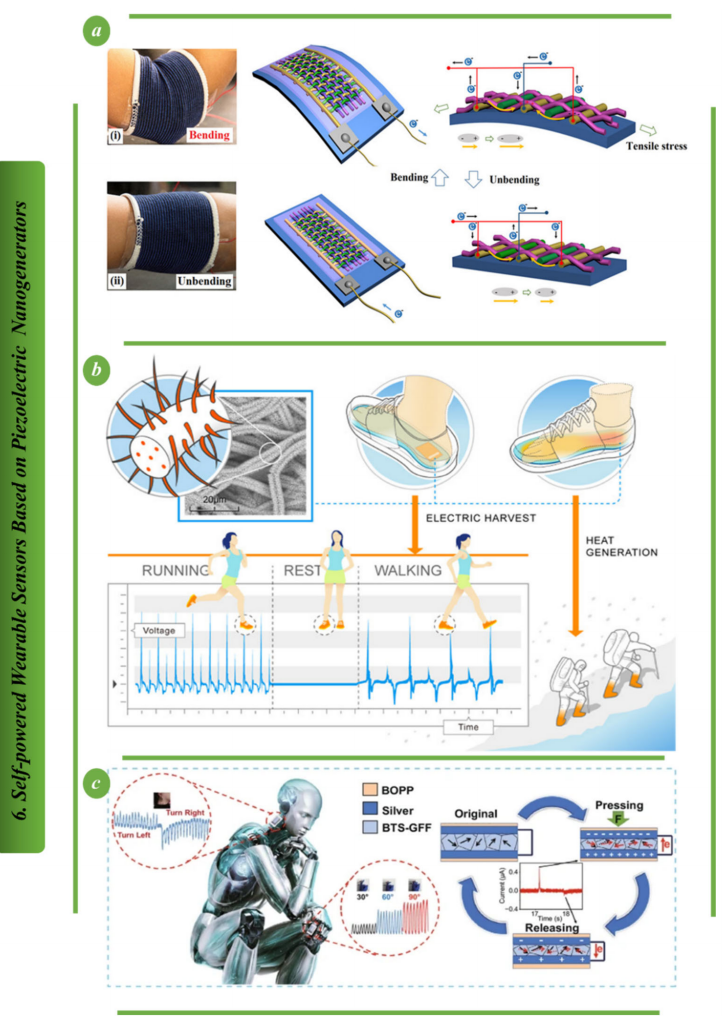
Figure 10. Self-powered wearable sensors based on PENG: ( a ) Illustration showing how FNG may extract usable energy from the motion of human bodies [101]. ( b ) Diagrammatic representation of the manufacturing process for the ZnO/PAN-based nano fabric that is used in the PENG [102]. ( c ) Super-flexible, lead-free piezoelectric nanogenerator for use in extremely sensitive self-powered sensors